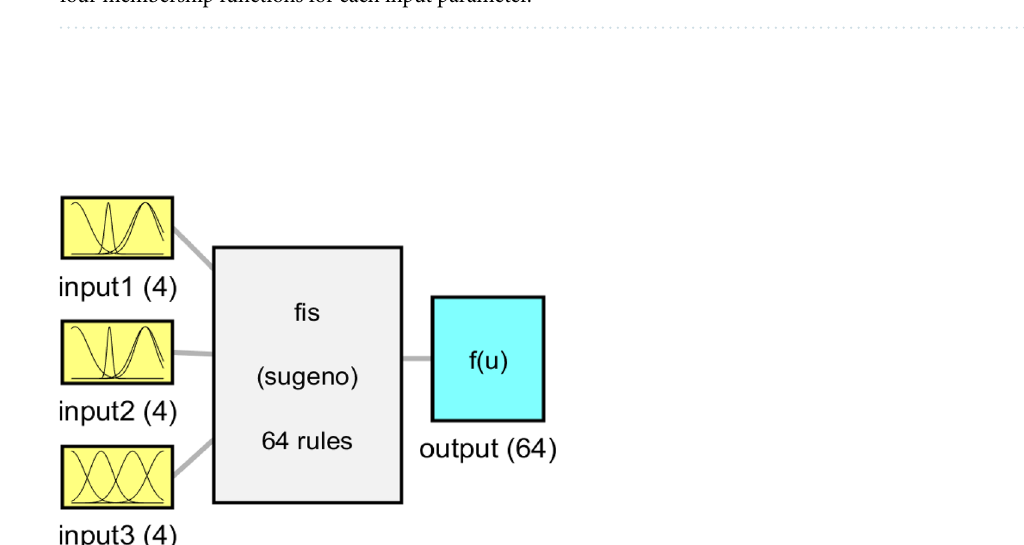
Figure 5. Degree of membership function, and the function performance as a function of the third input for four membership functions for each input parameter.